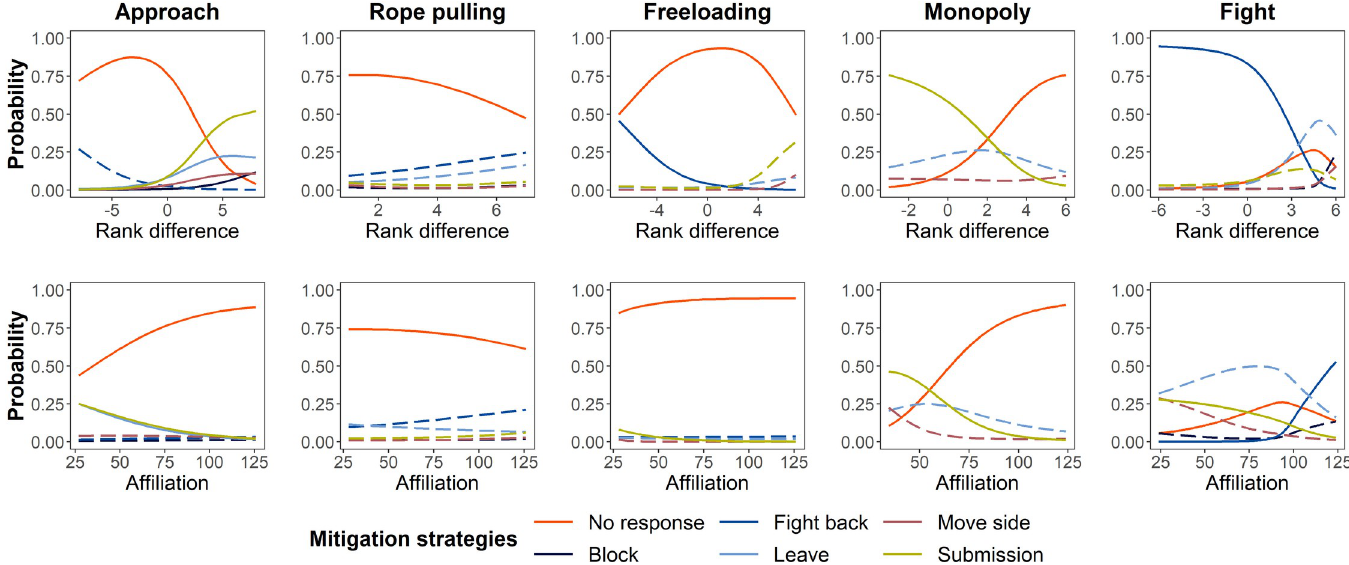
Fig 3. Mitigation strategies used by elephants in Phase I based on their rank difference with a partner (top) or their level of affiliation (bottom). Rank difference was calculated using the ranking of the initiator elephant minus the ranking of the target elephant. A positive rank difference means the initiator was dominant to the target elephant, while a negative value indicates the initiator was of lower rank. The only exception to this is that the rank difference under the “rope pulling” competition type was calculated as the absolute value of the rank difference between initiator elephant and target elephant, because we could not tell which individual initiated the behavior when 2 elephants pulled a single rope. The maximum affiliation index was 126. A solid line means that the probability of a mitigation strategy being used by an elephant can be predicted by rank difference (top plots) or affiliation (bottom plots), while long dashed lines represent nonsignificant patterns. The solid red line (no response) was set as a reference level in the models. The data used to generate this figure can be found in S1 Data. Fig 3, and the results of our between-elephant affiliation analysis (representing the closeness between elephants) are shown in S5 Table. Note that for Bayesian modeling results, we report the 95% credible intervals (CIs; reported within the text below and in S6 and S7 Tables). CI is reported as a range in brackets; if it does not cross zero, 0.00, the effect is significant.